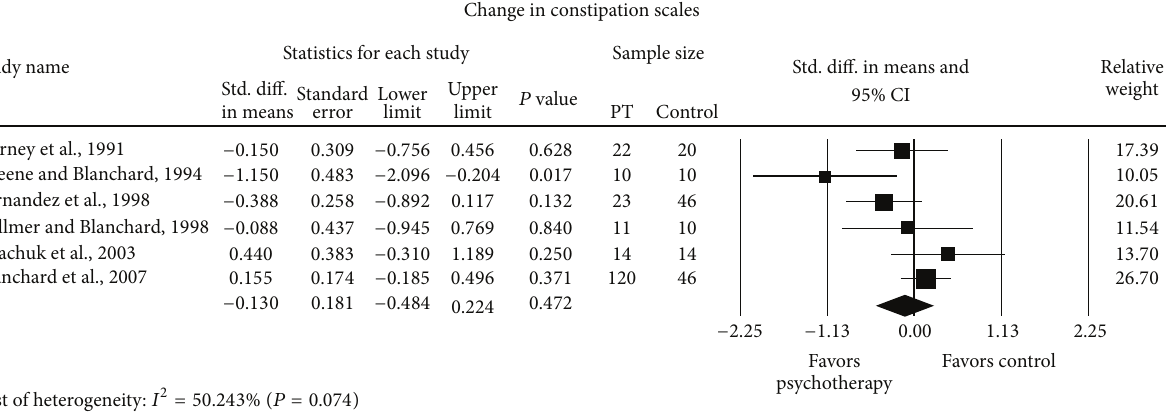
Figure 6: Forest plot for constipation scales in RCTs of psychotherapy (PT) versus control.